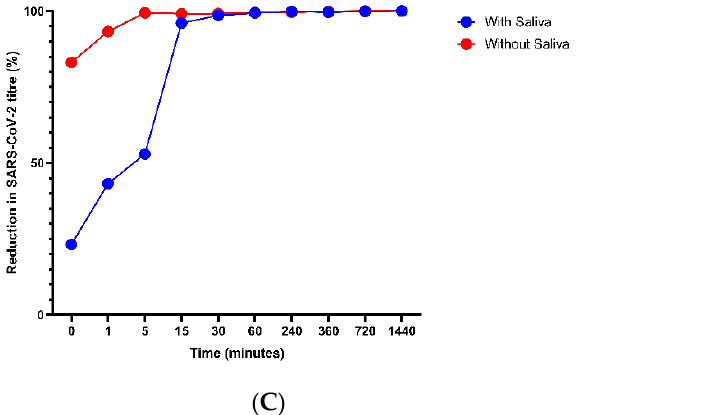
Figure 2. ( A ) Accumulated percentage reduction and ( B ) antiviral activity values of H1N1 and the ( C ) accumulated percentage reduction and ( D ) antiviral activity value of SARS-CoV-2 from Viruferrin-treated fabric samples collected at 10 time points (0 to 1440 min or 24 h). Virus percent reduction was calculated in relation to virus recovered from ( A , C ) the positive control while antiviral activity values ( B , D ) were calculated in relation to the cotton material control at timepoint 0, with and without the application of saliva. Antiviral activity values after 60 and 120 min, with and without saliva, respectively for H1N1 and 720 min for SARS-CoV-2 are not plotted as they are zero and it is necessary to calculate using the logarithmic values.